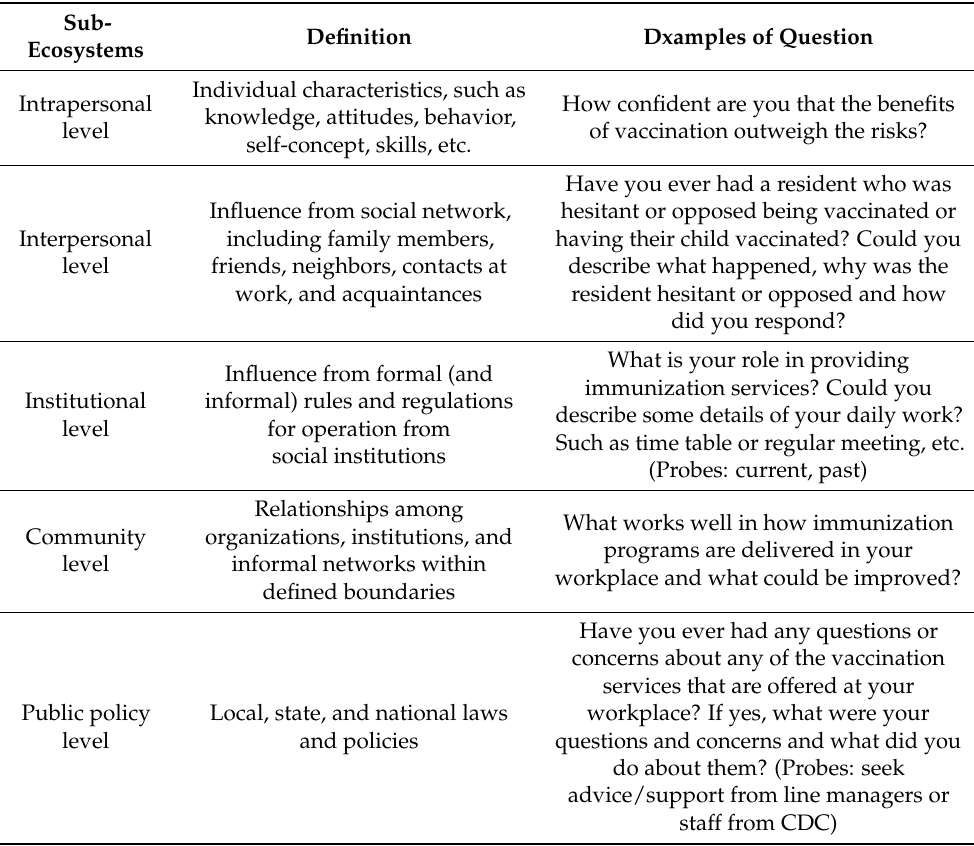
Table A3. Sub-ecosystems of social-ecological